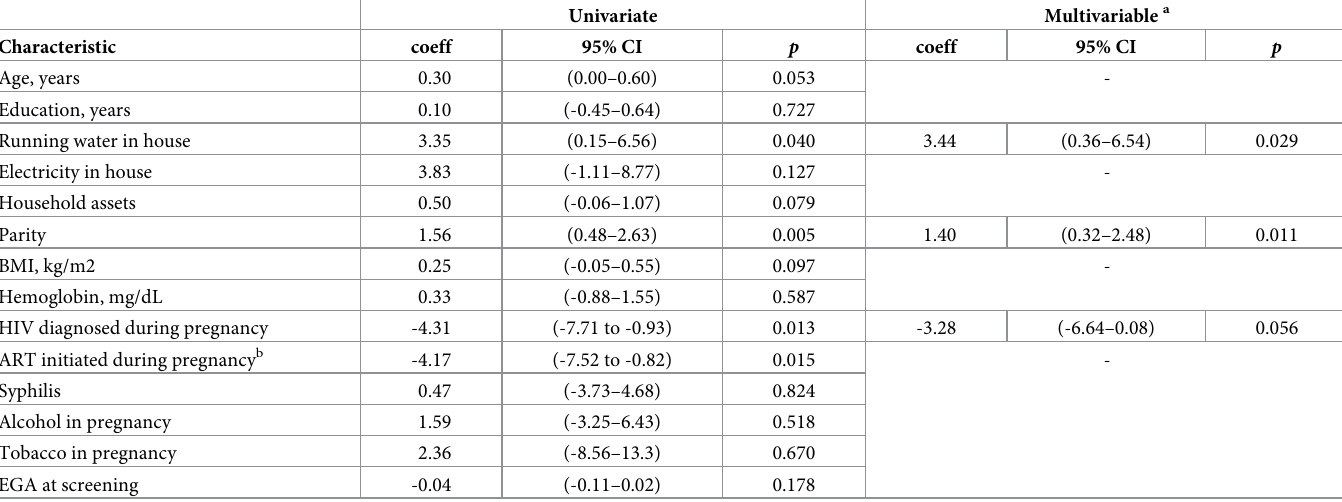
Table 4. Baseline correlates of adherence determined by dye stain assay of returned applicators.